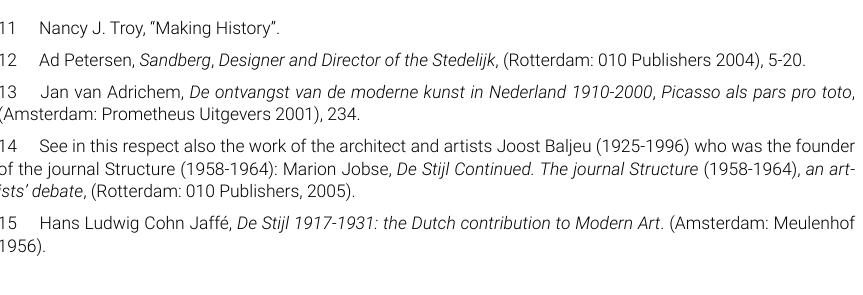
Fig. 1 Presentation of the Prix de la Critique by Hans Jaffé